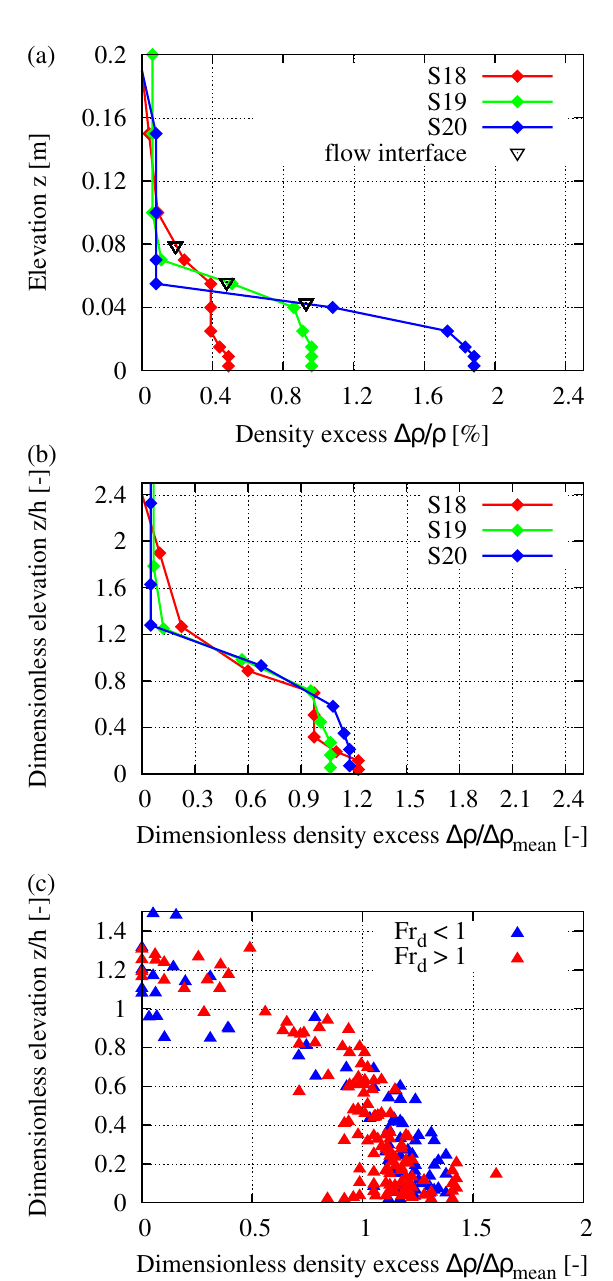
Figure 9. (a) Dimensional and (b) dimensionless density profiles measured in cross section C5 in experiments with di ff erent values of the inlet excess density, and the same value of flow discharge q 0 = 0 . 0017m 2 s − 1 . The black triangles indicate the flow interface level of each current. (c) Similarity plot of dimensionless density profiles measured in all the experiments performed (both saline and turbidity currents) and classified in terms of the densimetric Froude number.